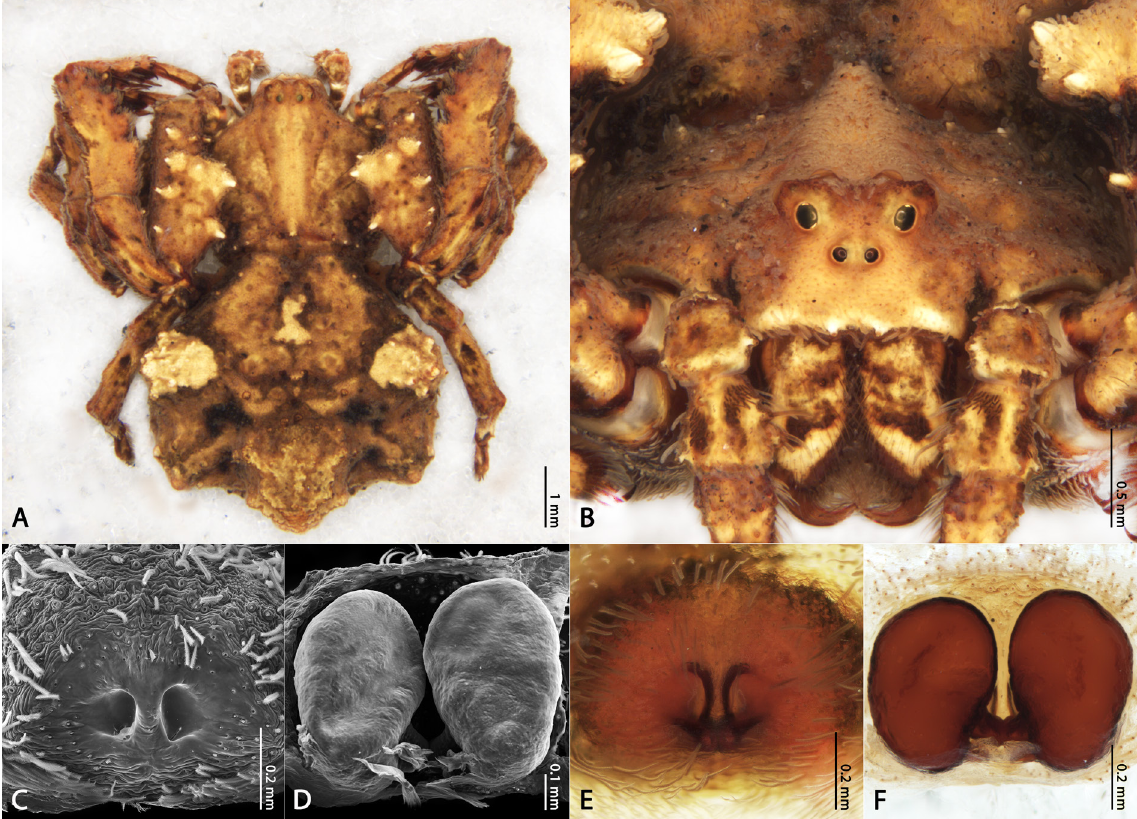
Fig. 16. Kryptochroma septata Machado & Teixeira gen. et sp. nov., holotype, ♀ (UFMG 18269). A . Habitus, dorsal view. B . Front. C, E . Epigynal plate, ventral view. D, F . Spermathecae, dorsal